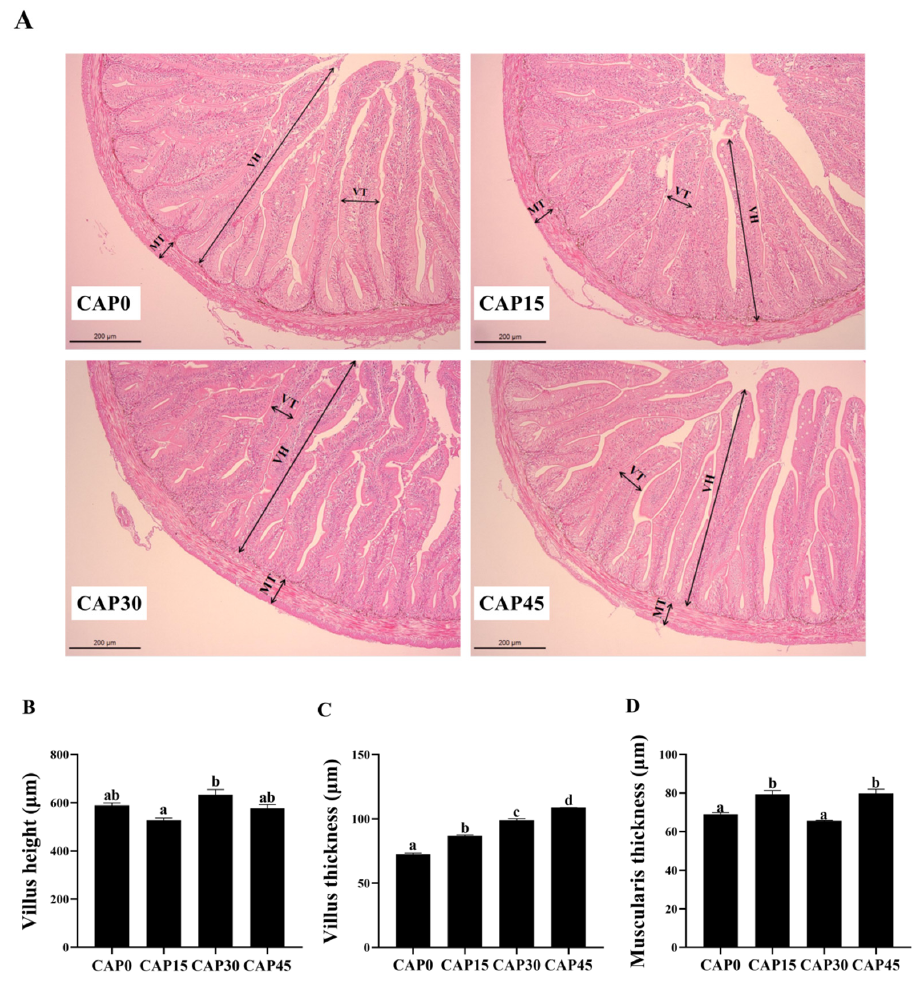
Figure 1. ( A ) Observation of gut morphology of large yellow croakers fed diets with different levels of CAP ( Clostridium autoethanogenum protein) by H&E staining (200 × ) for 56 days. VH (Villus height), VT (Villus thickness), MT (Muscularis thickness). ( B ) Villus height, ( C ) Villus thickness and ( D ) Muscularis thickness. Bars with different letters indicate significant difference ( p < 0.05).